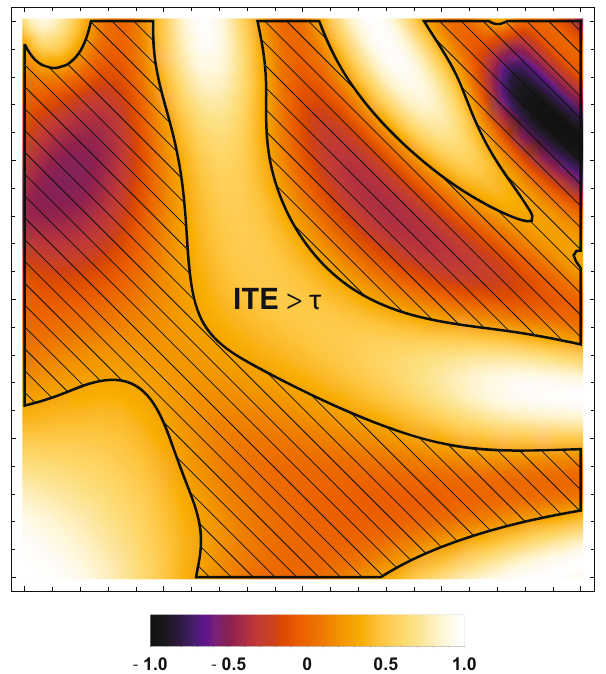
Figure 1: Di ff erence between estimating and optimising ITE. The region labelled τ ITE > is considered the optimalregion, given some τ ; the shaded area indicates the suboptimal region. This fi gure illustrates the di ff erence between mere CATE prediction – that is estimatingthecoloureddensityplot – anddecision - makingbasedonathreshold, τ ,andtheestimatedITE –